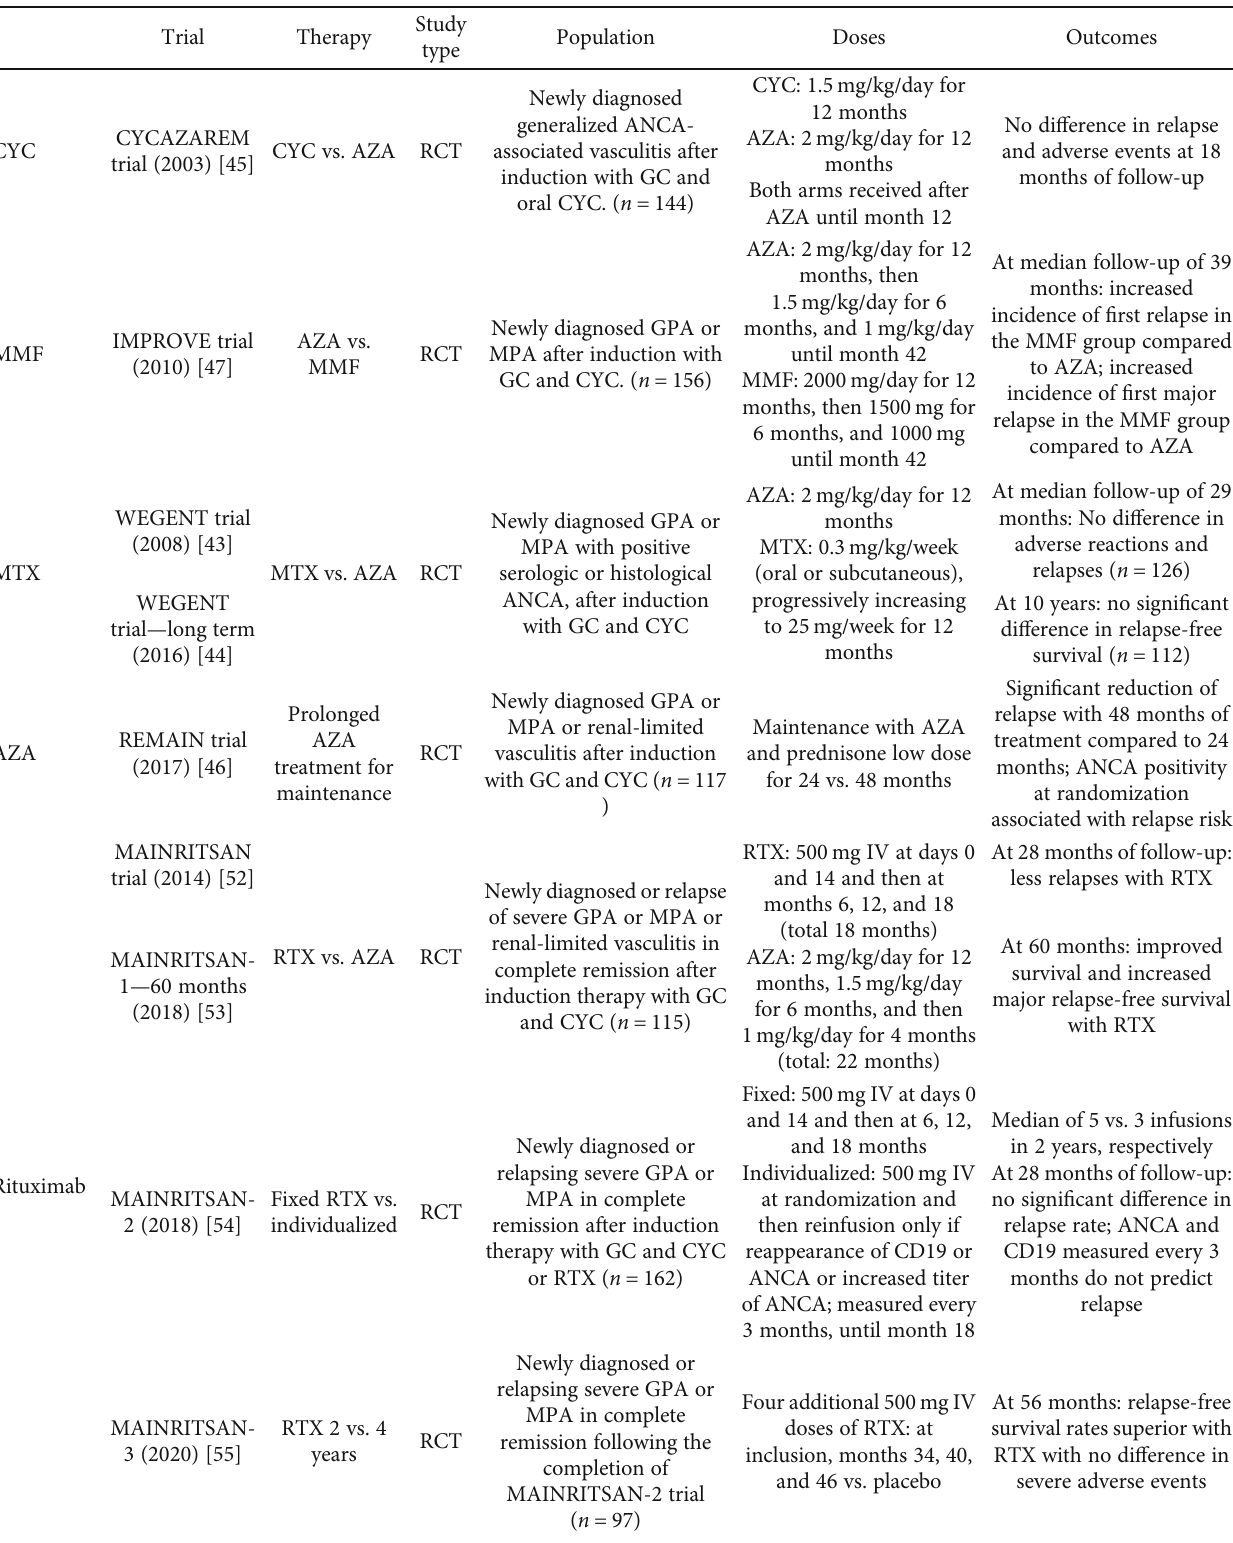
Table 2: Maintenance therapy trials of ANCA-associated vasculitis discussed in this